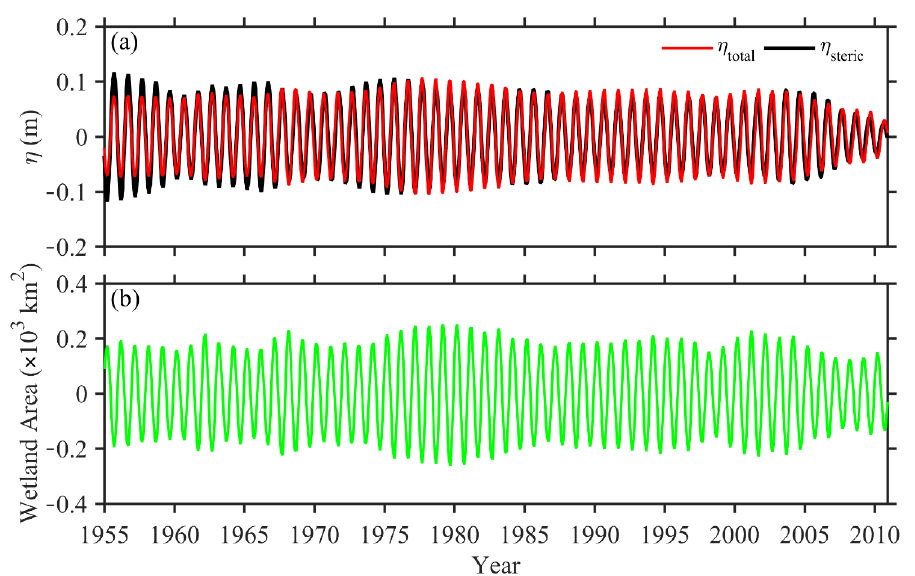
Figure 8. Seasonal variations of ( a ) the domain-averaged total and steric sea surface height anomalies, and ( b ) the wetland area.